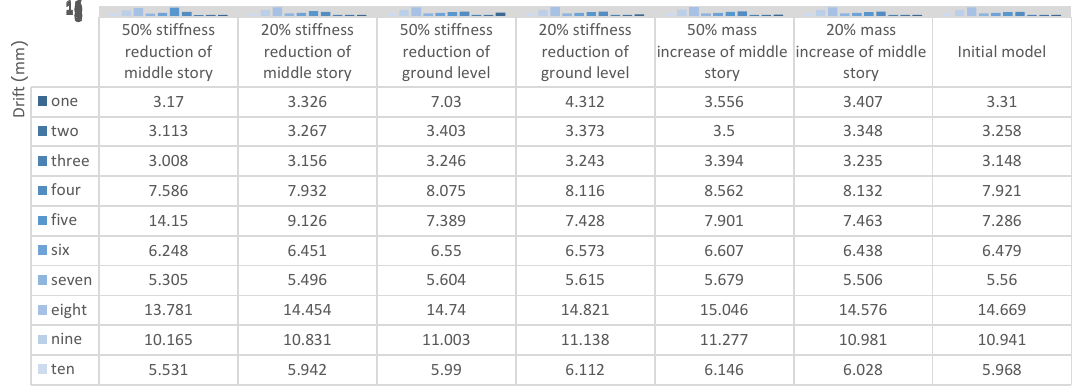
Fig. 12. Drift of 10 story